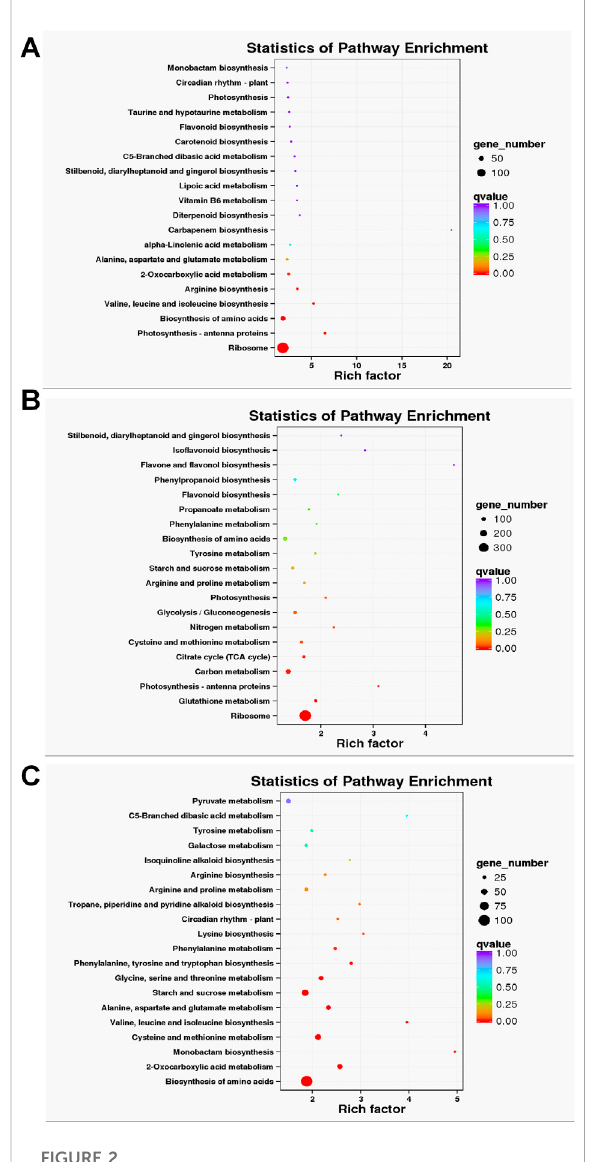
FIGURE 2 KEGG enrichmentanalysisof DEGs in0 vs. 48 h (A) , 0 vs. 72 h (B) 48 vs. 72 h (C) , which showed only the top 20 pathways with the most signi fi cant enrichment.